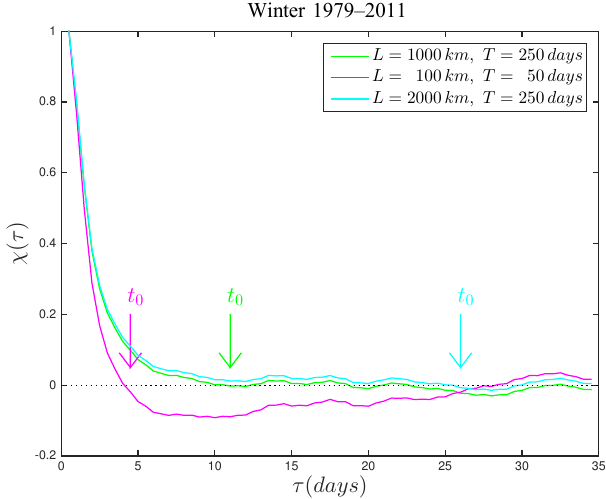
Figure 3. Ensemble average autocorrelation function of the fluctu- ating velocities computed from the IABP dataset for winter seasons 1979 to 2011 with three different averaging scales. The first zero- crossing time t 0 is given for